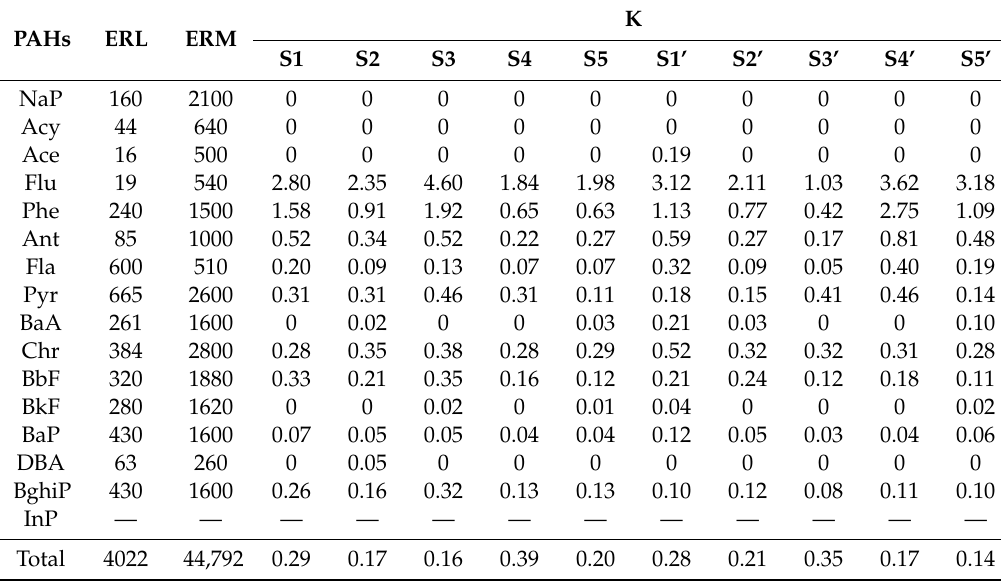
Table 4. Ecological risk assessment of PAHs in the